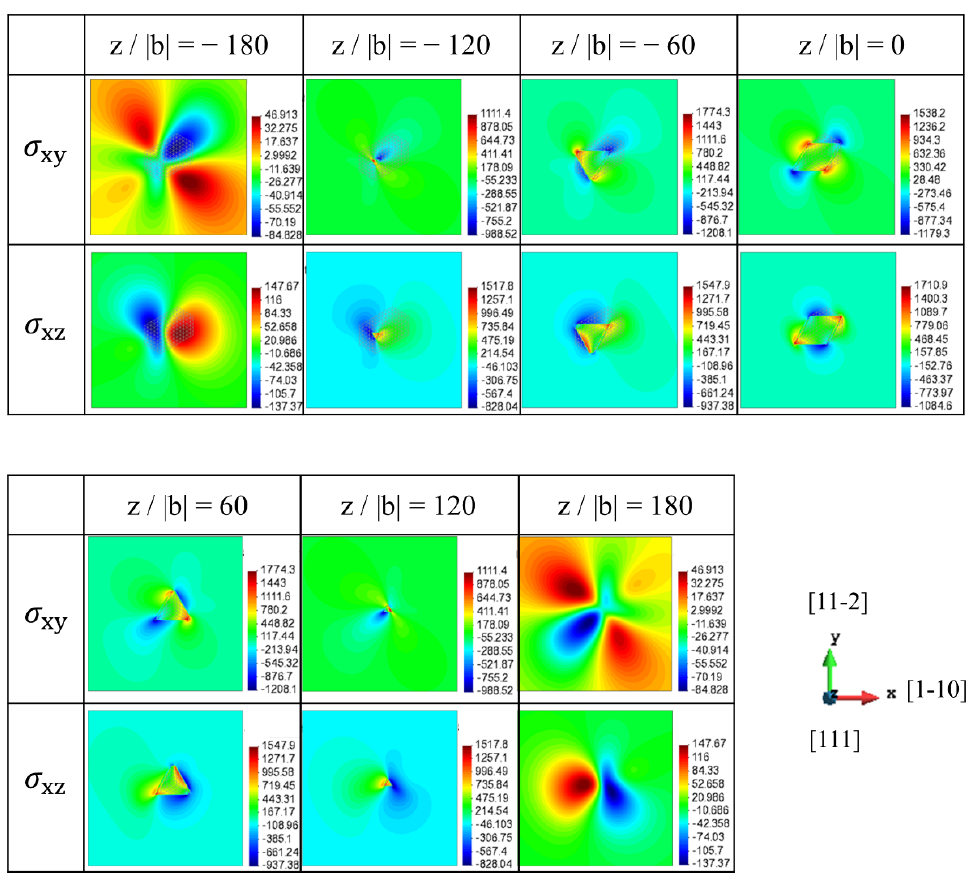
Figure 3. Stress field of [100] rod on the (111) slip plane (Type-B variant). σ xy and σ xz in dislocation coordinate are represented at the different positions (z/|b| = −180 to 180).